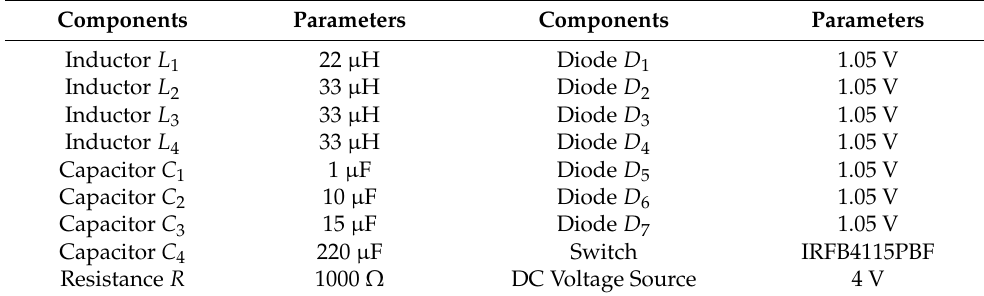
Table 4. Circuit parameters and number of